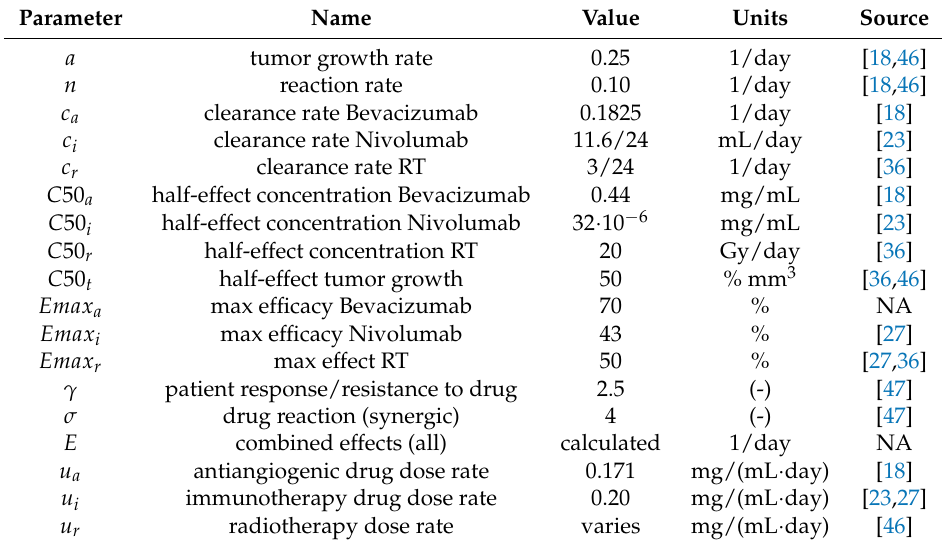
Table 2. PKPD model coefficients values and units used in this study and the corresponding literature source. NA denotes source not available. Data from animal studies (mice).